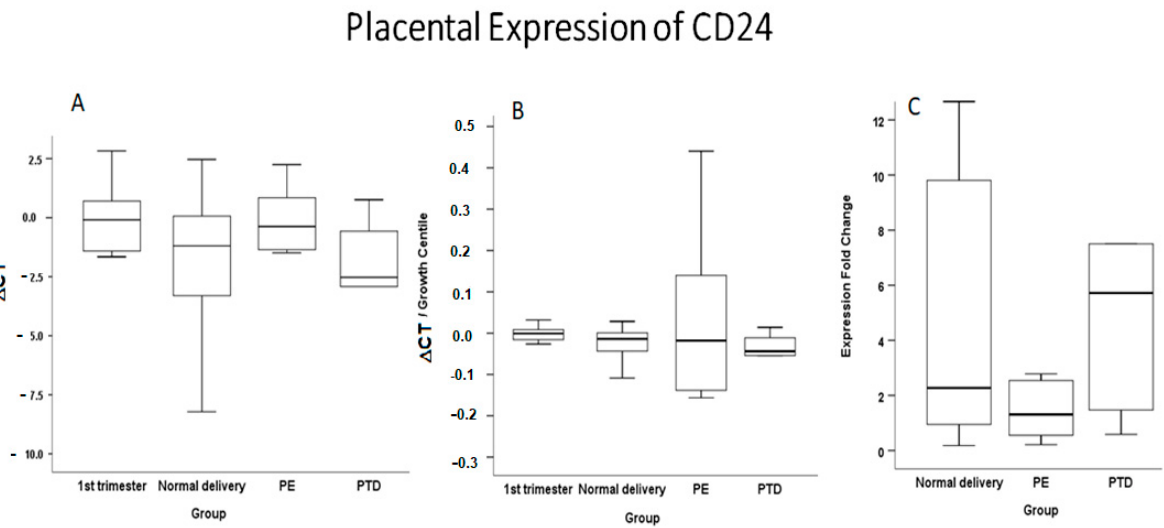
Figure 1. Box plot of placental mRNA expression of CD24. ( A ) Δ CT, ( B ) Δ CT versus fetal growth, ( C ) expression fold (2 − Median ΔΔ CT ) change.